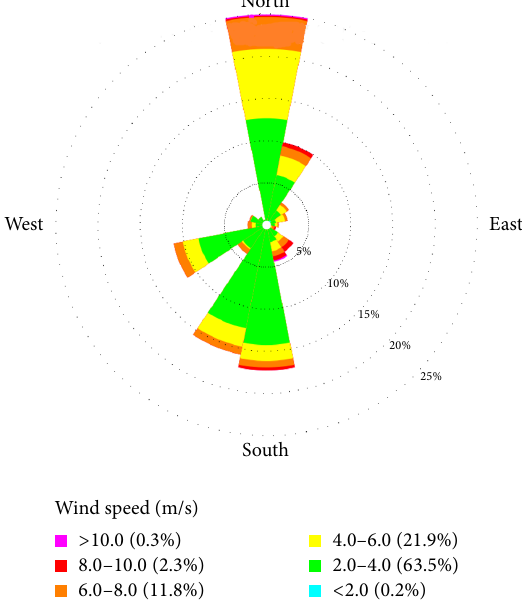
Figure 11: Polar diagram: wind direction for Pala.